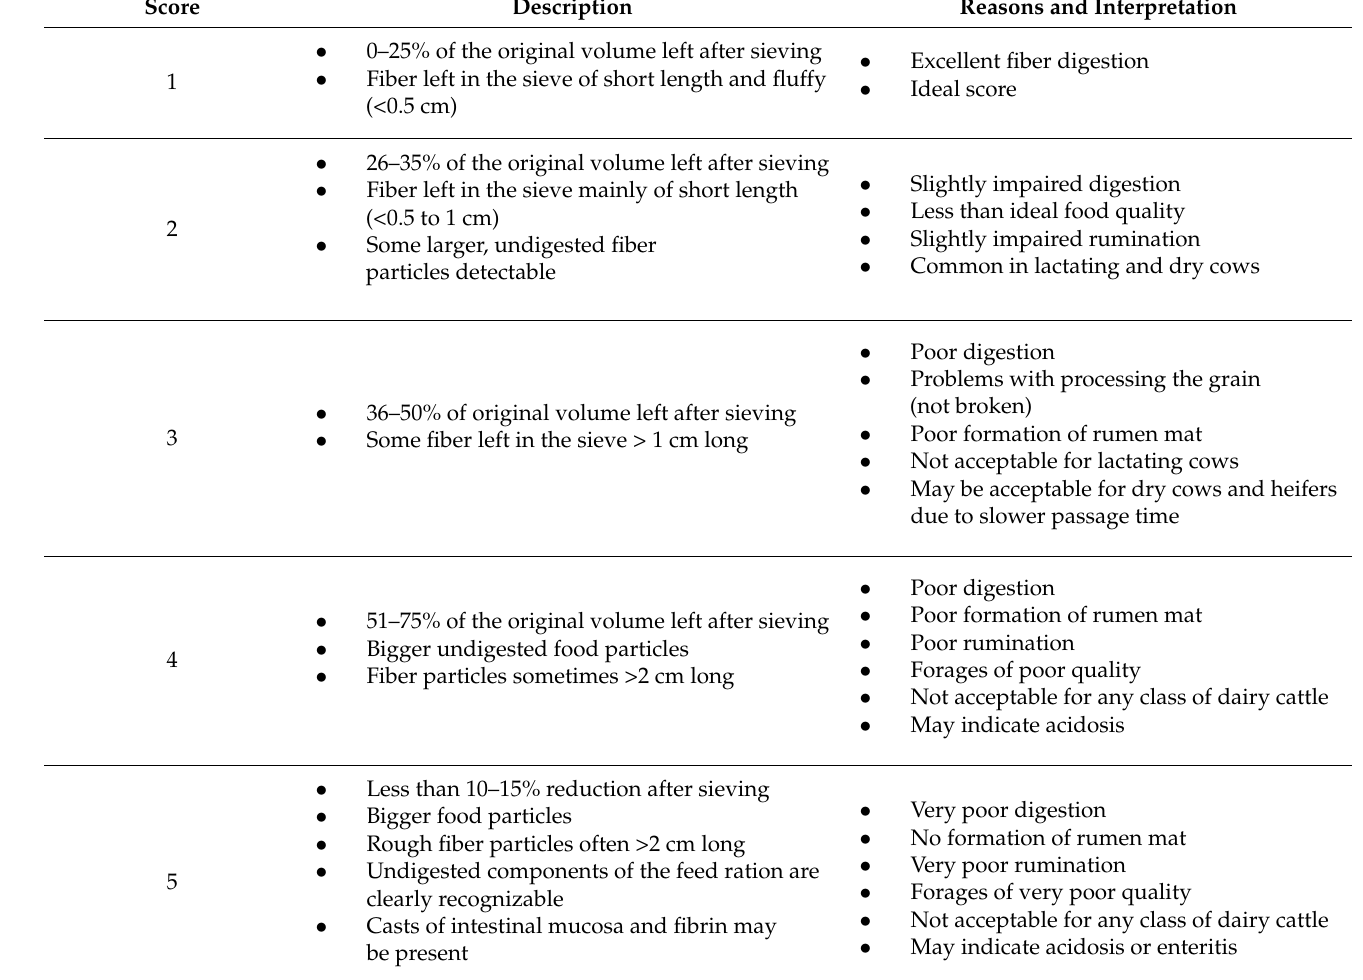
Table 4. Scoring of the digestive function by sieving for 30 s with a gentle ‘massaging’. Score Description Reasons and